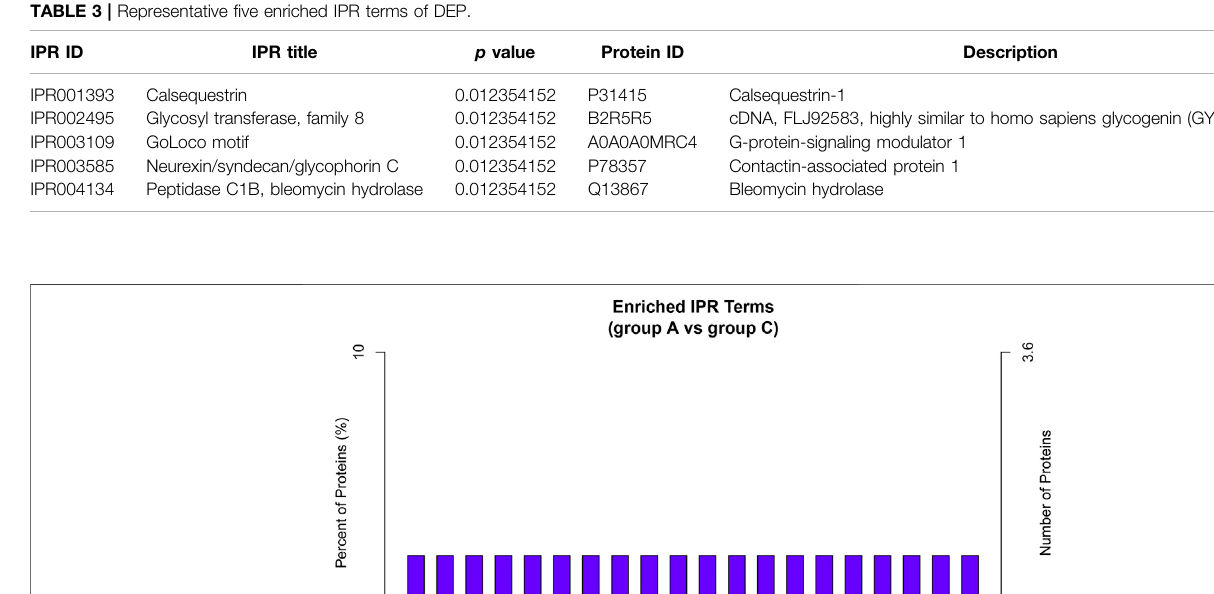
Supplementary Table S3 . In organisms, different proteins